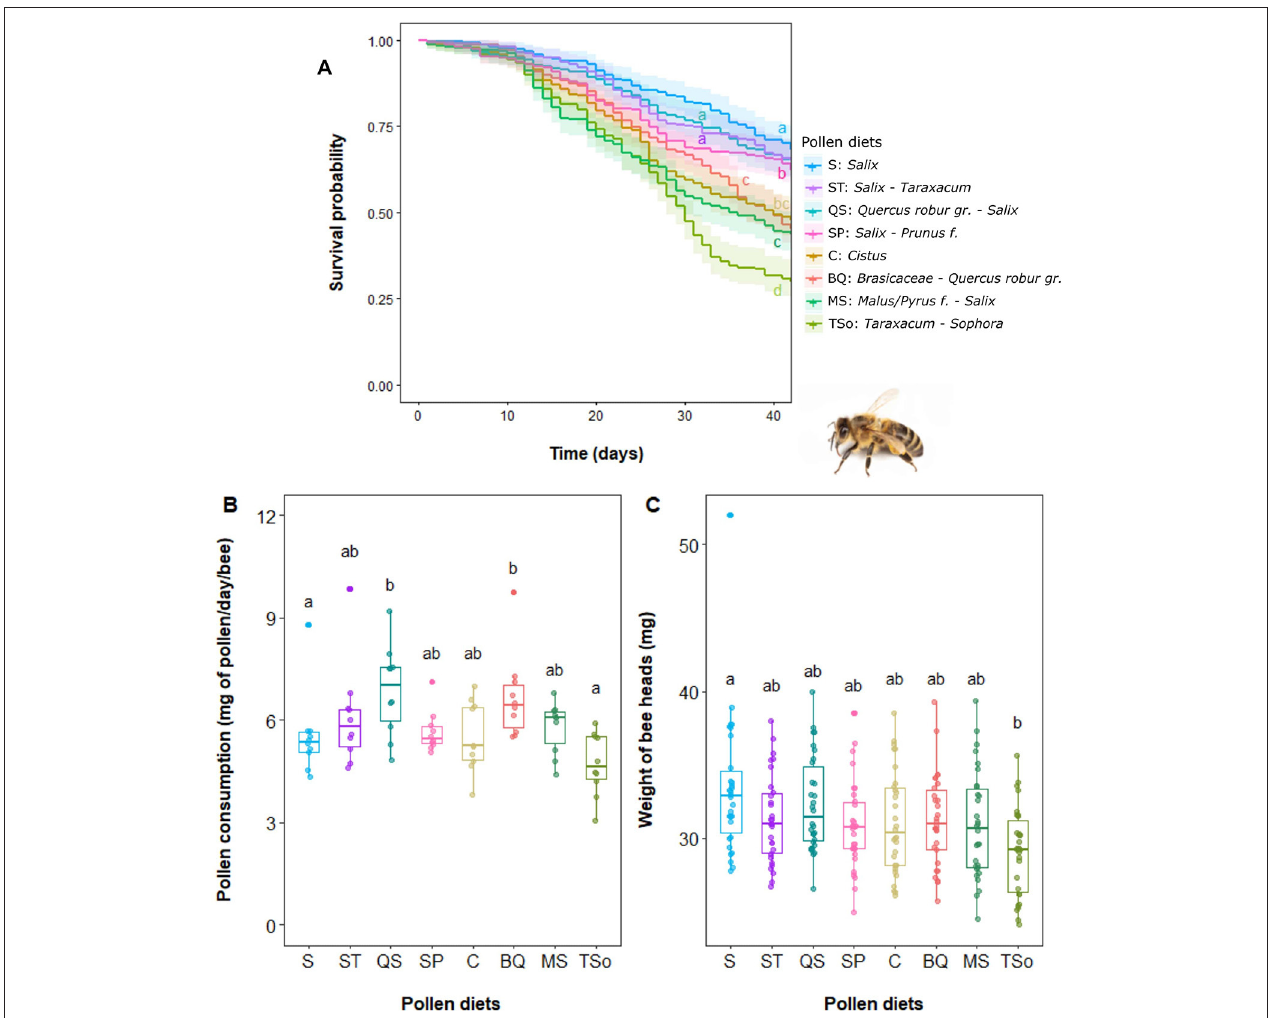
FIGURE 2 | Influence of pollen diets on Apis mellifera . (A) Survival probability ( n = 30 bees per cage and 10 cages per pollen regime), (B) pollen collection and (C) head weight. Boxes indicate the 1st and 3rd interquartile range with line denoting median ( n = 30 pools of 3 bees per pollen). Whiskers include 90% of the individuals, beyond which each outlier are represented by circles. Different letters indicate significant differences between pollen diets (Kruskal-Wallis tests followed by Dunn’s multiple comparison tests: p <